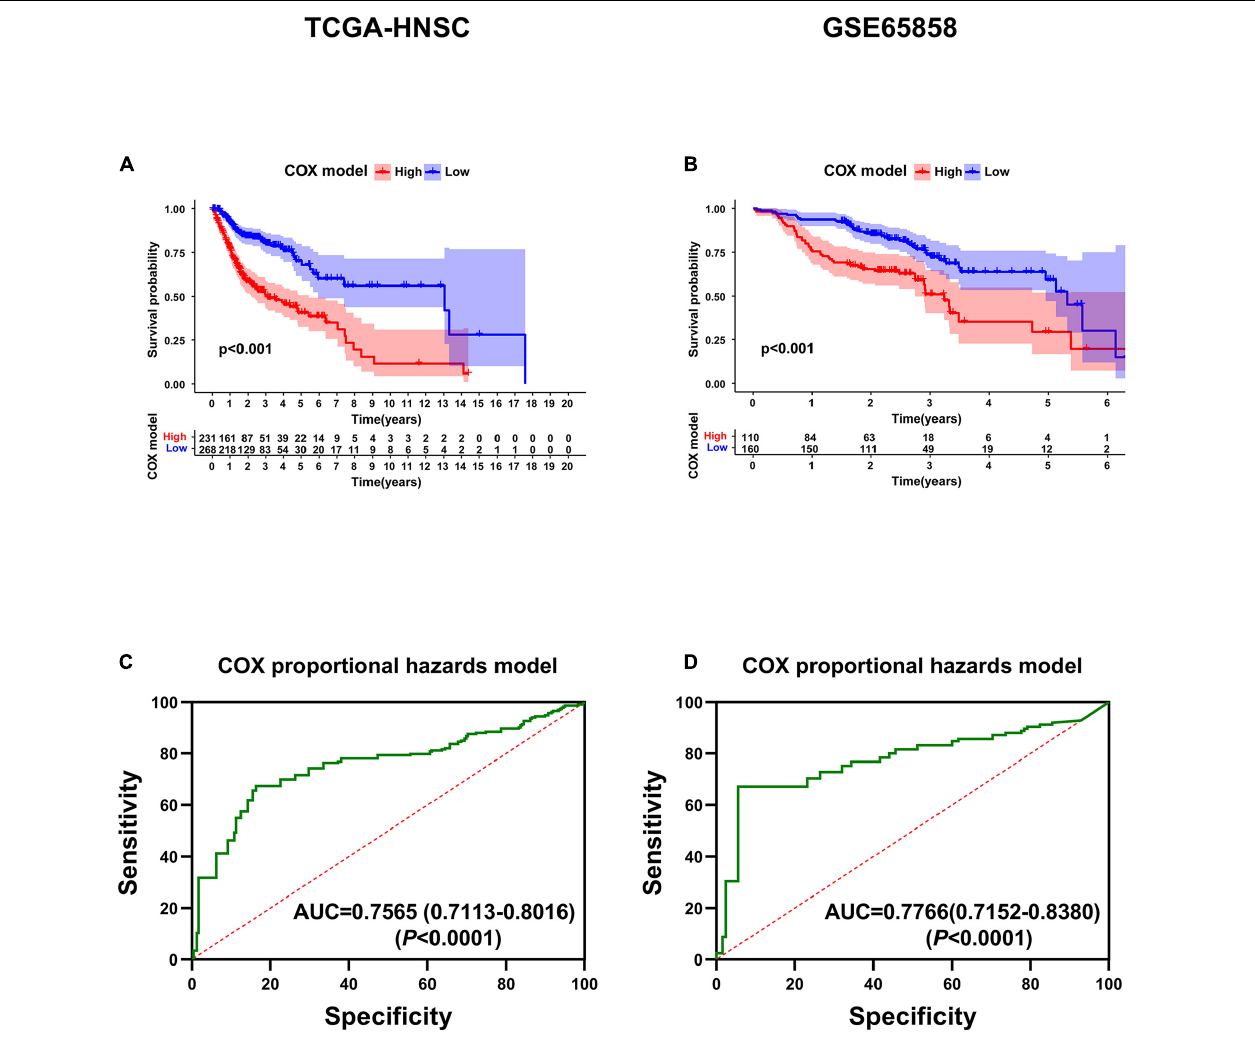
FIGURE 6 | Validation of the six-gene prognostic signature. (A) Survival analysis of the prognostic signature in TCGA. (B) Survival analysis of the prognostic signature in GSE65858. (C) AUC in ROC analysis for the signature at overall survival in TCGA. (D) AUC in ROC analysis for the signature at overall survival in